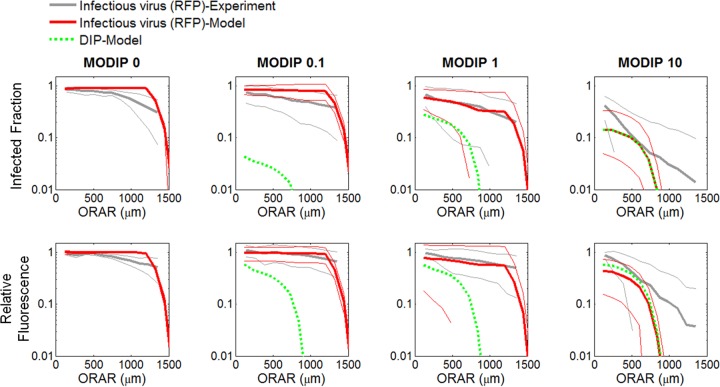
Comparison of experimental and computational (CA model) patterns of coinfection spread. The infected fraction (ordinate) (top) and relative fluorescence (ordinate) (bottom) over concentric rings around the plaque center (ORAR [abscissa]) from experiments (gray lines) and models (red lines) are shown. The thick and thin solid lines represent means and standard deviations, respectively. Green dashed lines represent the fractions of DIP-producing cells and relative DIP yields from the CA model. All CA models employed parameter set 2.